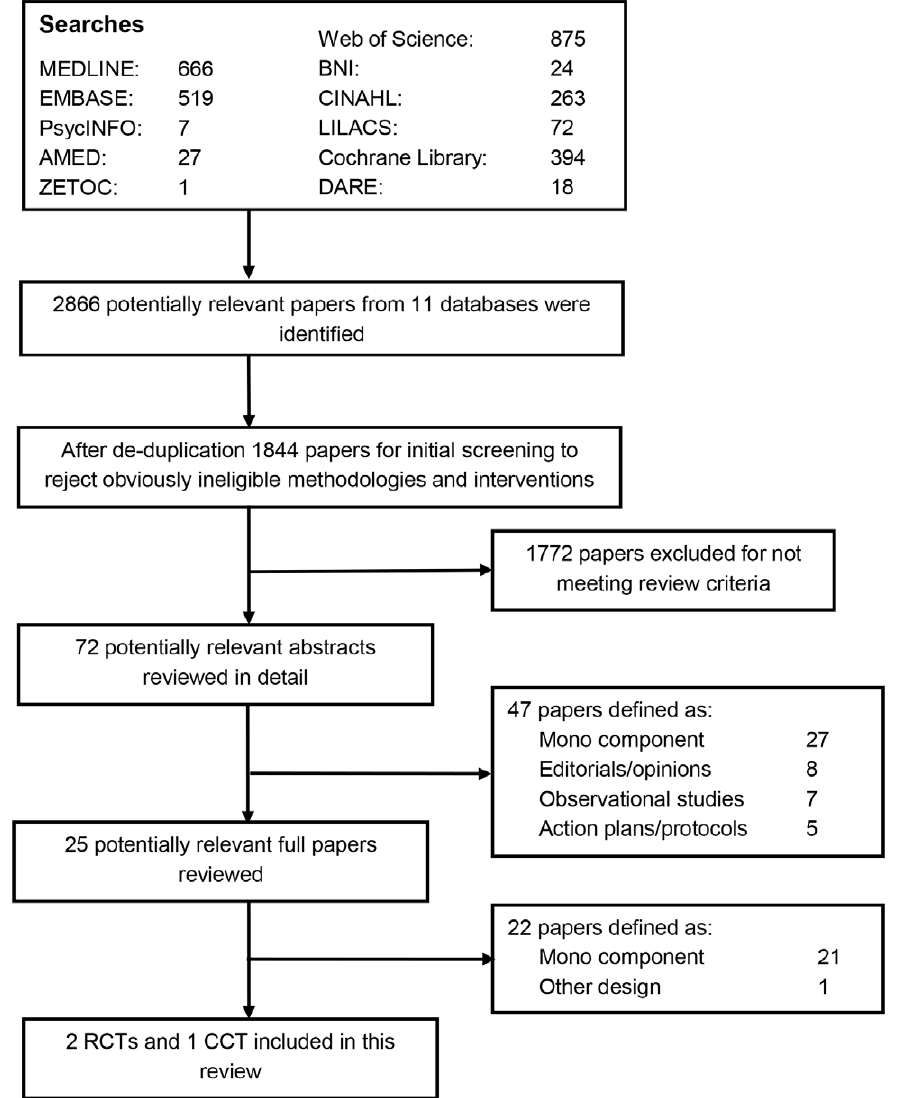
Figure 1. PRISMA flow diagram.